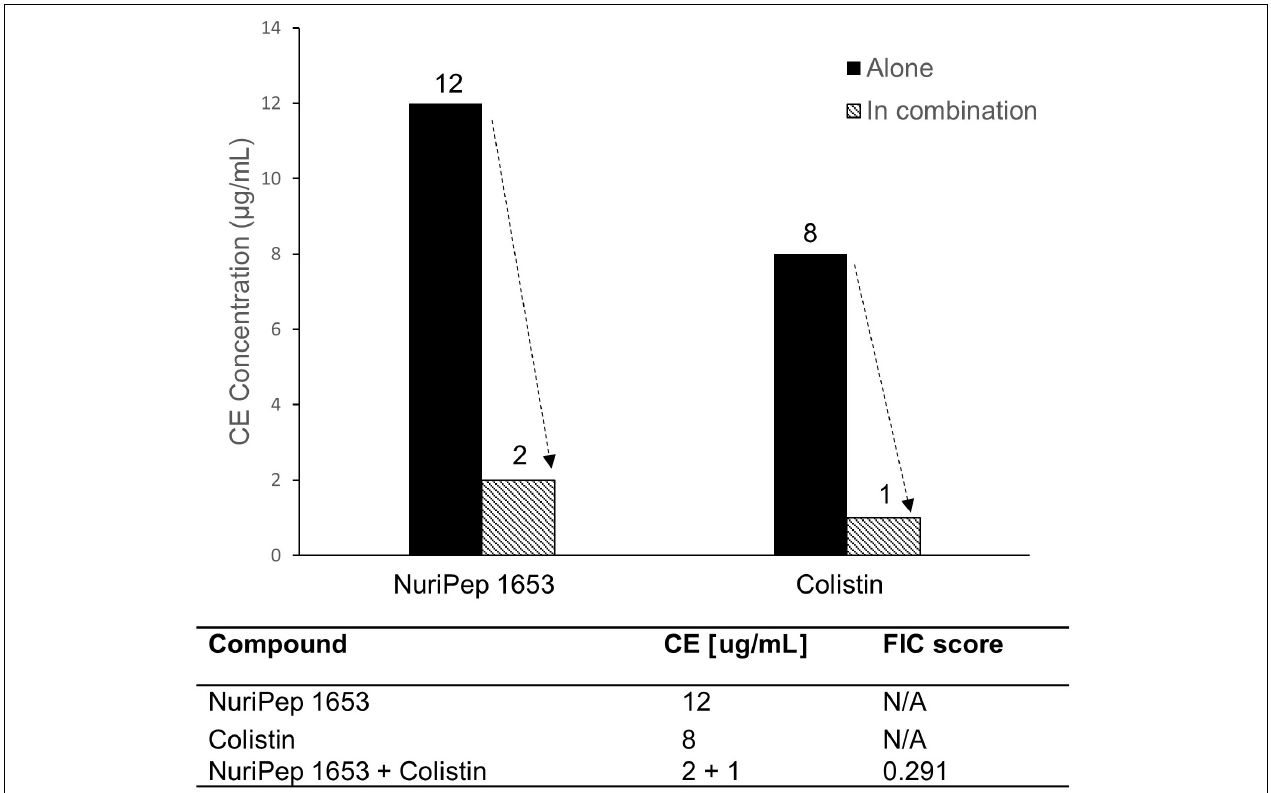
FIGURE 5 | Assessment of synergistic interactions between NuriPep 1653 and colistin against colRAB. Changes in CE concentration observed with NuriPep 1653 and colistin against colRAB when tested alone versus in combination to determine synergistic effects. A FIC index score of 0.291 for both peptides combined indicates synergy.